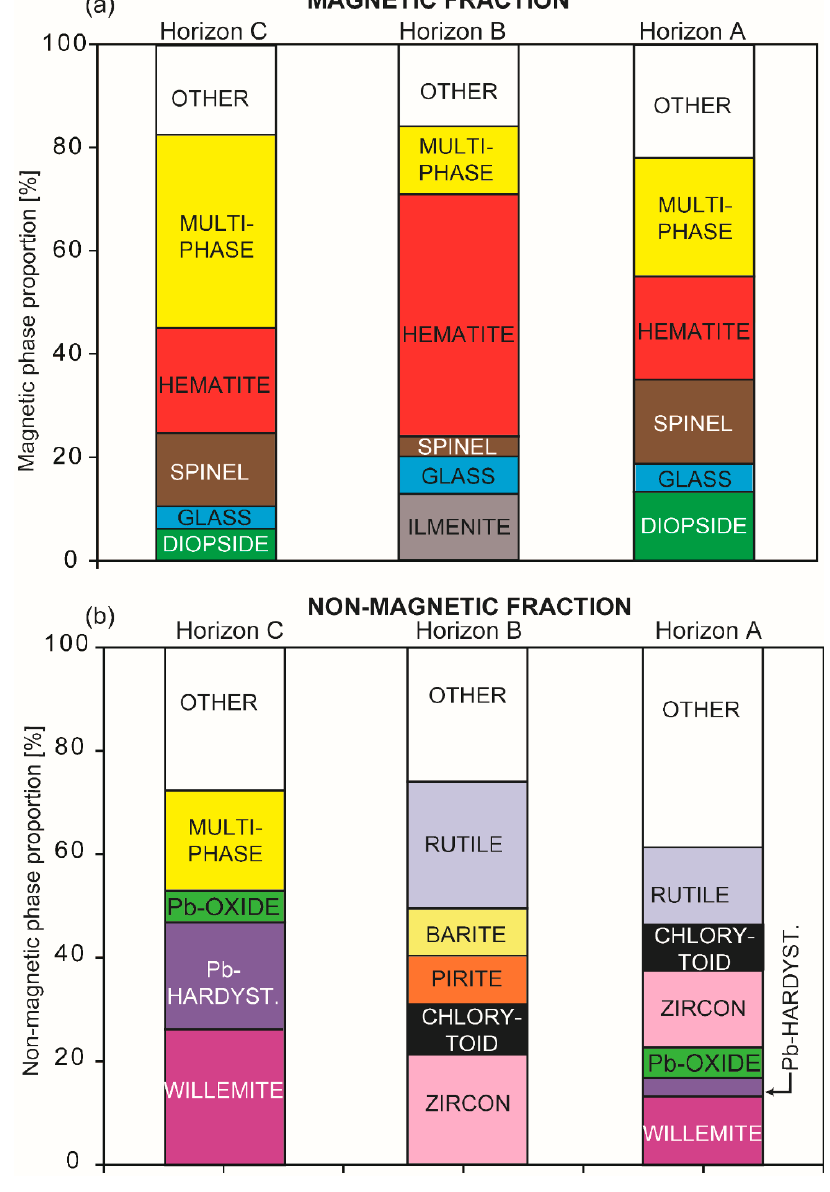
Figure 4. Simplified modal compositions of the heavy mineral fraction in terms of magnetic ( a ) and non-magnetic phases ( b ) from all three horizons. Gahnite and hercynite are shown as a single spinel group. All the secondary multi-phases were also grouped as a single group (multi-phases). The proportion of minerals shown is in % area of analysed particles.